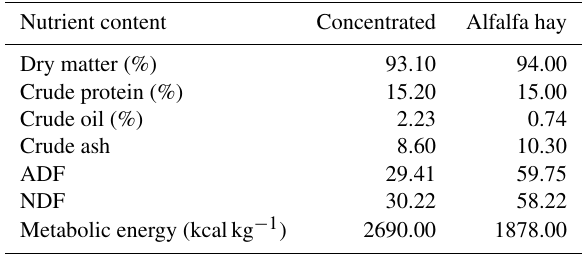
Table 1. The chemical composition of concentrate feed and alfalfa